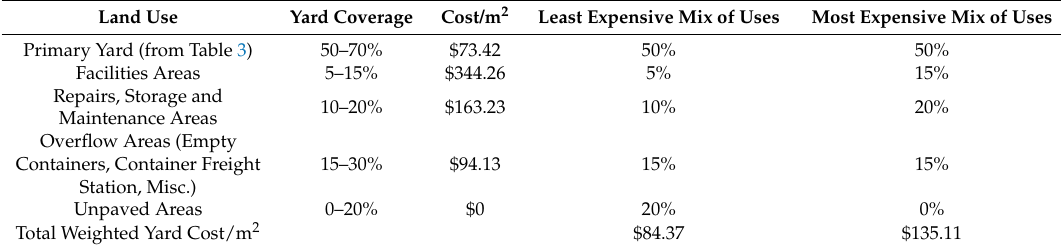
Table 5. Unit costs to reconstruct the yard for each land use type were used to calculate the weighted total yard cost per square meter, including surface and structure reconstruction cost components (2012 US dollars). Most expensive mix of uses maximizes land use devoted to facilities, repairs, and maintenance. Least expensive mix of uses maximizes unpaved areas.